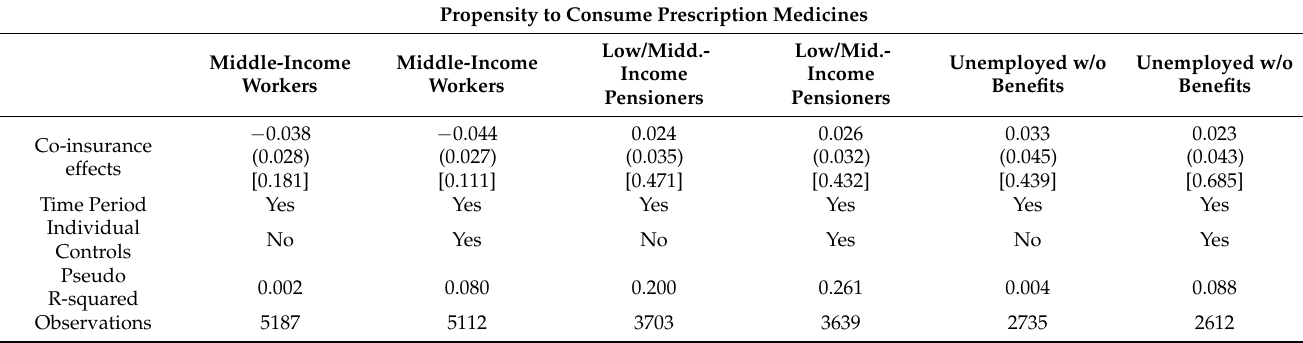
Table A1. Results for the propensity to consume prescription medicines using non-linear estimation method